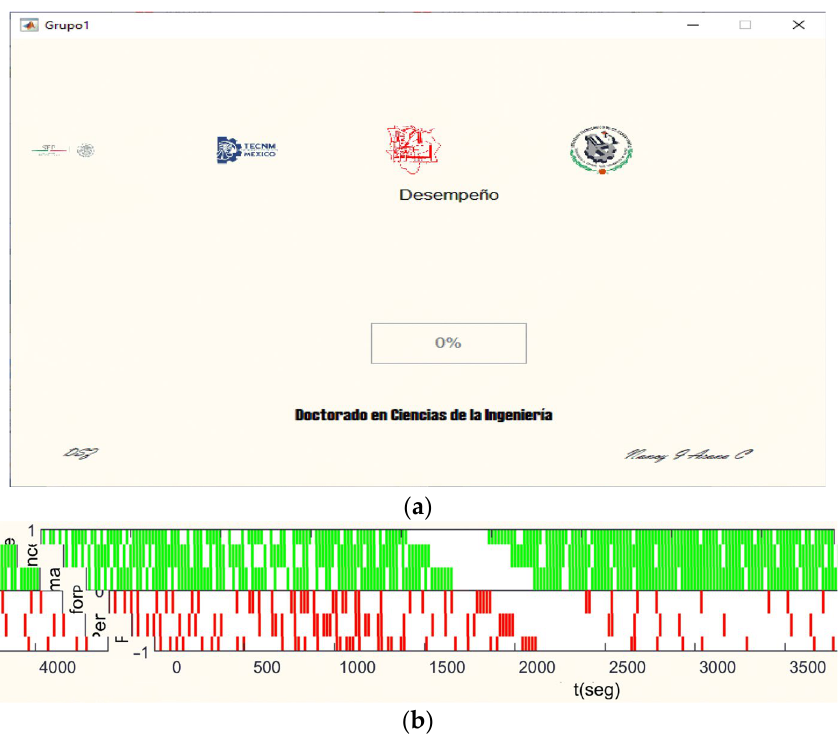
Figure 4. ( a ) Mental Workload GUI screen showing performance in percentage in Spanish; ( b ) Mental Workload GUI screen showing performance over the session time (rights and wrongs). Table 2. Excerpt of the hierarchical breakdown into the list of sub-tasks, elementary tasks, and specific